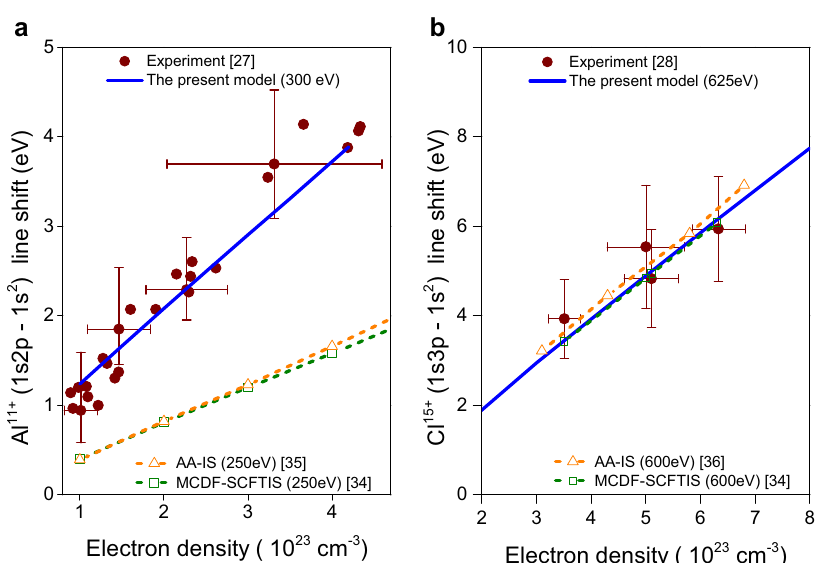
Fig. 4 Line-shift results comparison. a , b The comparison of line shifts from experiments and different calculations for a 1 s 2 p − 1 s 2 transition in Al 11 + and b 1 s 3 p − 1 s 2 transition in Cl 15 + . The dots are the experimental data, and the error bars are the uncertainties of the measurements 27,28 . The theoretical line- shift results are obtained by using the present screening model (solid line), MCDF-SCFTIS 34 (dash line with squares), and AA-IS models 35,36 (dash line with